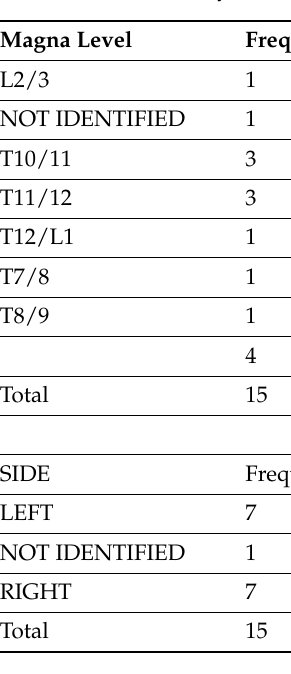
Table 1. Foraminal entry-level and side of the Artery of Adamkiewicz